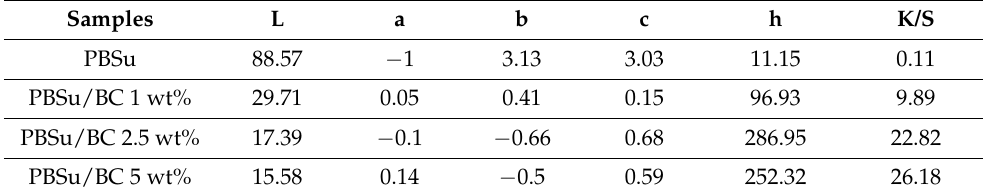
Table 5. Colorimetric data L*, a*, b*, C*, h°, and K/S values of the PBSu/BC samples.